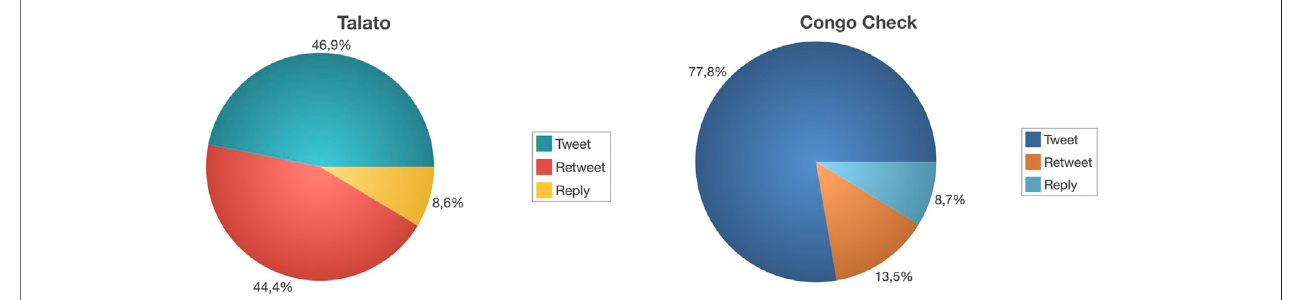
FIGURE 1 | Types of Twitter posts from ABCA and Congo